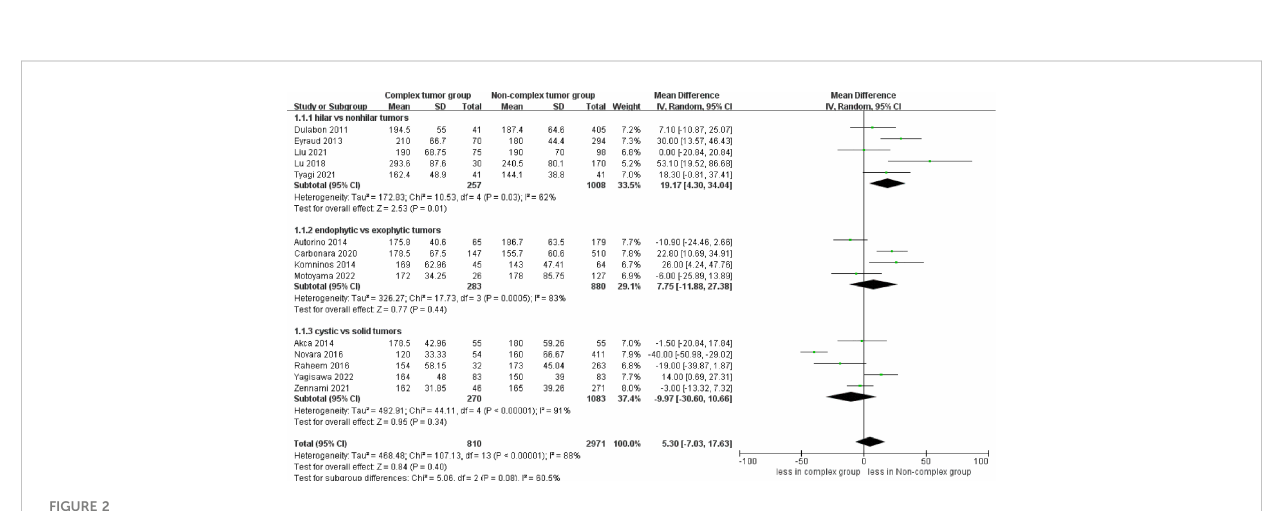
FIGURE 2 Forest plots of perioperative outcome- operative